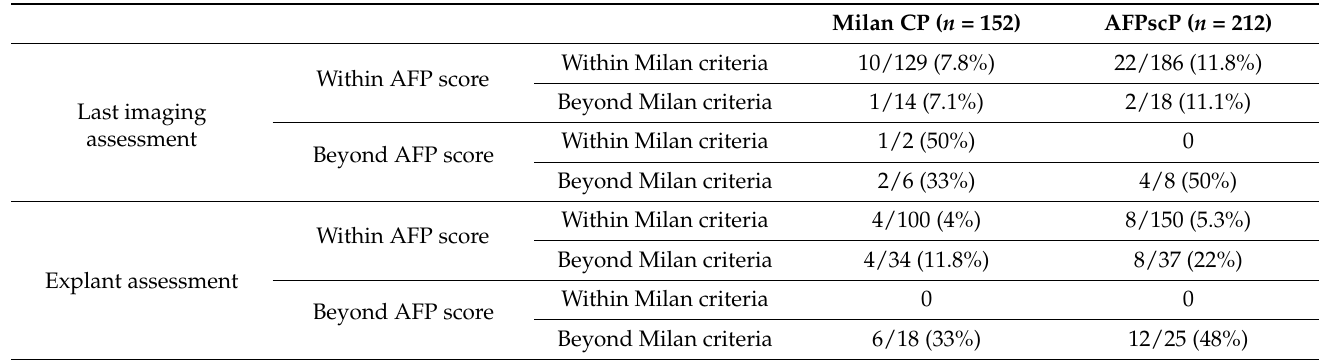
Table 4. Recurrence rate for each group of patients based on AFP score and Milan criteria on last-imaging assessment and on explant findings in transplanted patients during Milan criteria period of time and during AFP score period of time. Milan CP ( n =